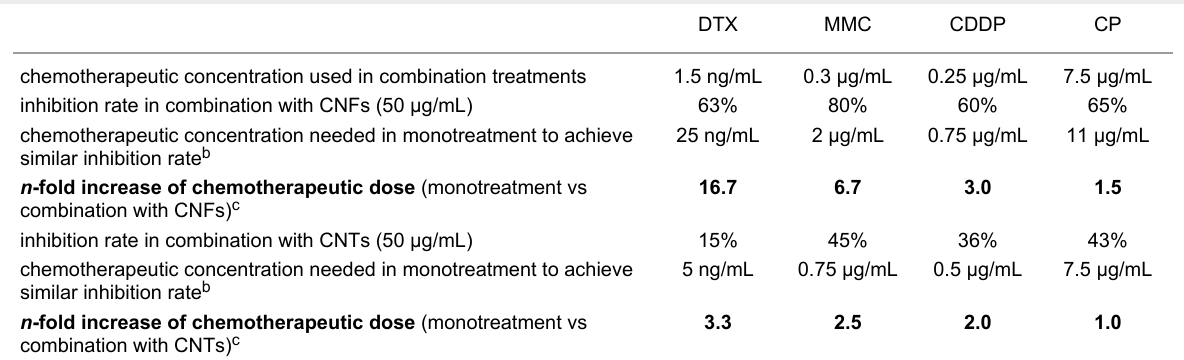
Table 2: Viability inhibition rates of the combinatory treatments in comparison to the monotreatments with chemotherapeutics based on present and previous findings [28]. a